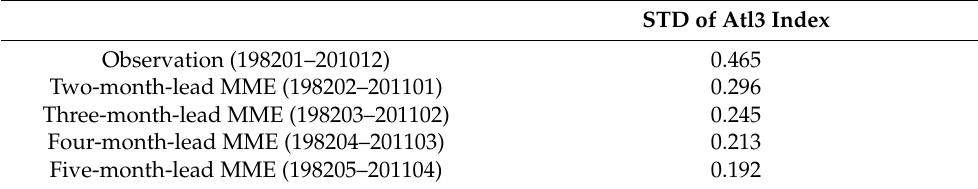
Table 2. The standard deviation of the observed Atl3 index and the predicted Atl3 index in MME. The time series of the predicted Atl3 index is displayed by colored lines in Figure 1c.